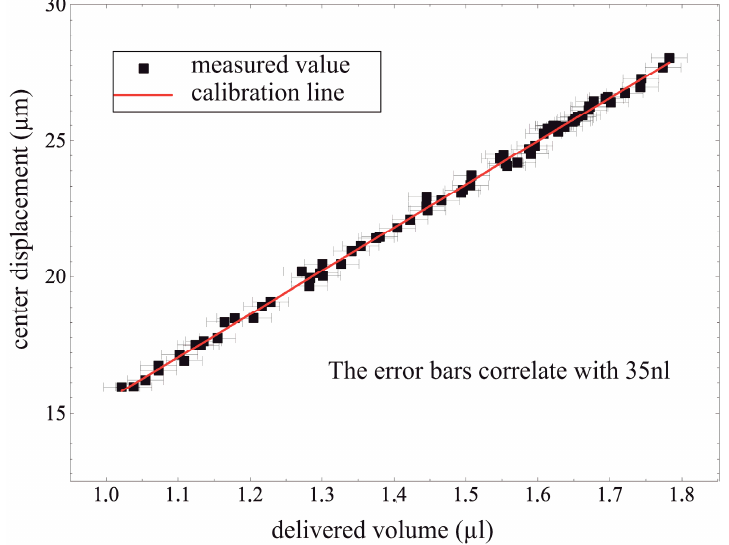
Figure 14. Delivered volumes in relation to the center displacement. The delivered volume deviates from the calibration line by a maximum of 35